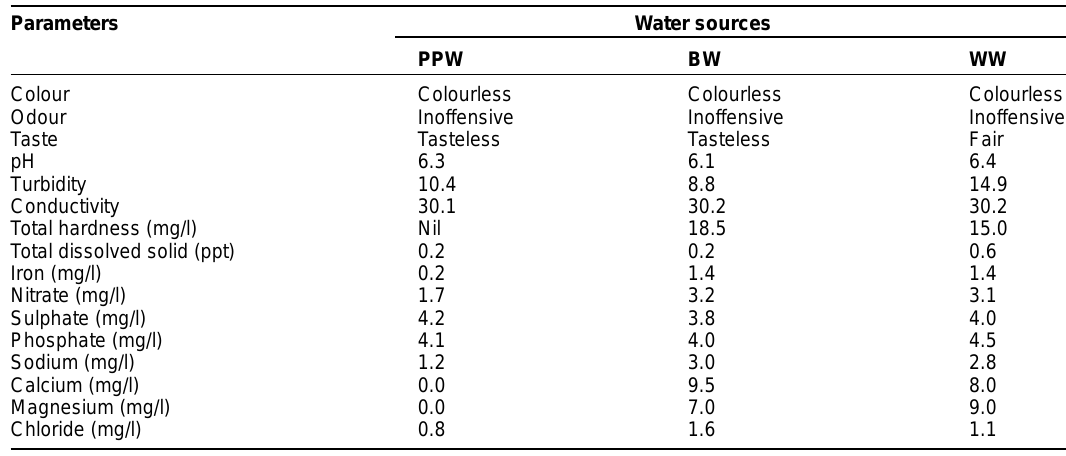
Table-1. Physico-chemical analysis of sampled water Parameters